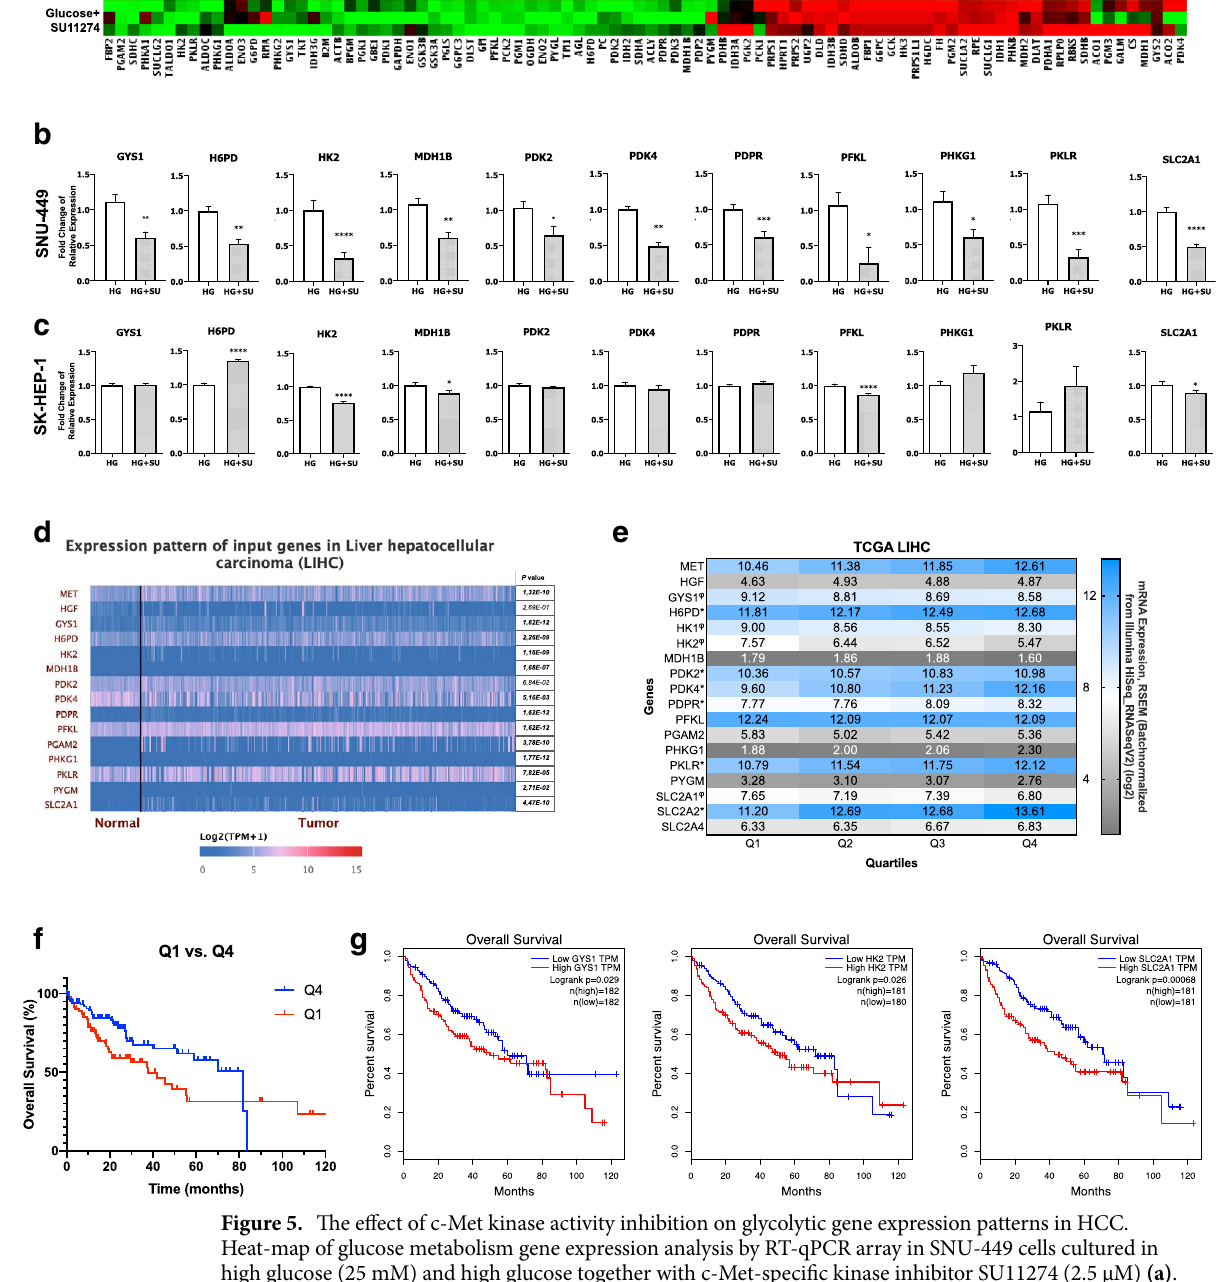
Figure 5. The effect of c-Met kinase activity inhibition on glycolytic gene expression patterns in HCC. Heat-map of glucose metabolism gene expression analysis by RT-qPCR array in SNU-449 cells cultured in high glucose (25 mM) and high glucose together with c-Met-specific kinase inhibitor SU11274 (2.5 μM) (a) . RT-qPCR validation of genes differentially expressed in RT-qPCR array experiments (GYS1, H6PD, HK2, MDH1B, PDK2, PDK4, PDPR, PFKL, PHKG1, PKLR) and glucose transporter GLUT1 (SLC2A1) in SNU-449 ( b ) and SK-HEP-1 cells treated with high glucose (25 mM) and high glucose together with c-Met-specific kinase inhibitor SU11274 (2.5 μM) (c) . Heat-map presentation of indicated genes’ expression in normal and tumor tissue samples from patients in TCGA-LIHC dataset. Expression heat-map and adjusted p-value s were generated with UALCAN from TCGA-LIHC dataset ( d) . Comparative expression analysis of indicated genes in TCGA- LIHC quartiles that were grouped according to MET expression (e) . φ: significantly lower in high- MET